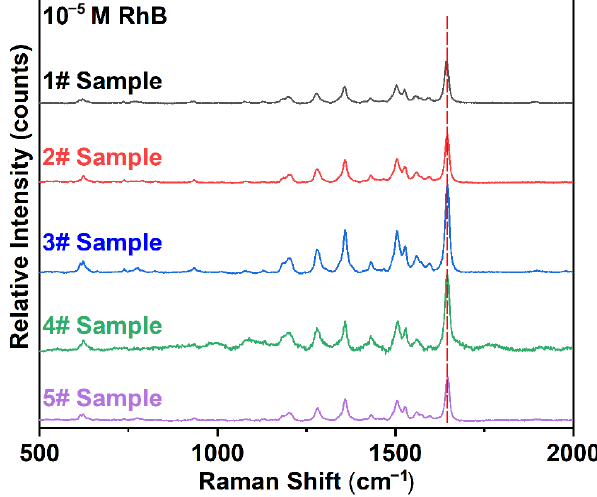
Figure 3. SERS spectra of the electrochemical dealloyed samples dealloyed for different times with 10 −5 M RhB adsorbed. Table 2. Experimental and the literature SERS shifts of RhB molecules.